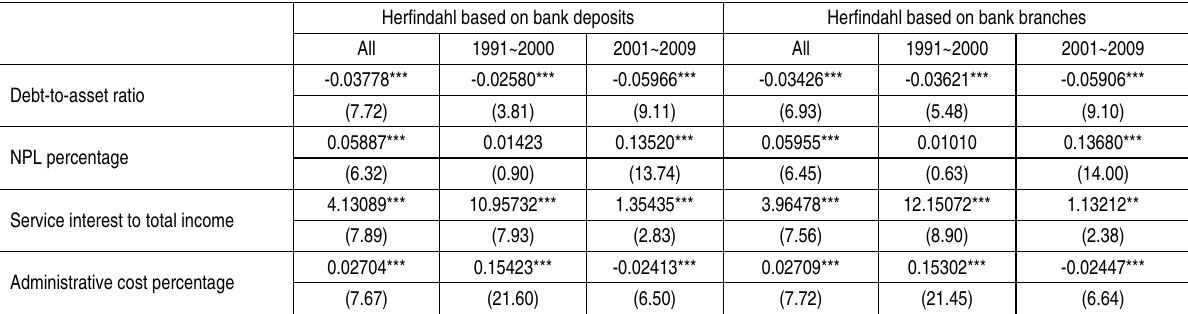
Table 7. Herfindahls based on bank deposits and branches – adding macroeconomic information Herfindahl based on bank